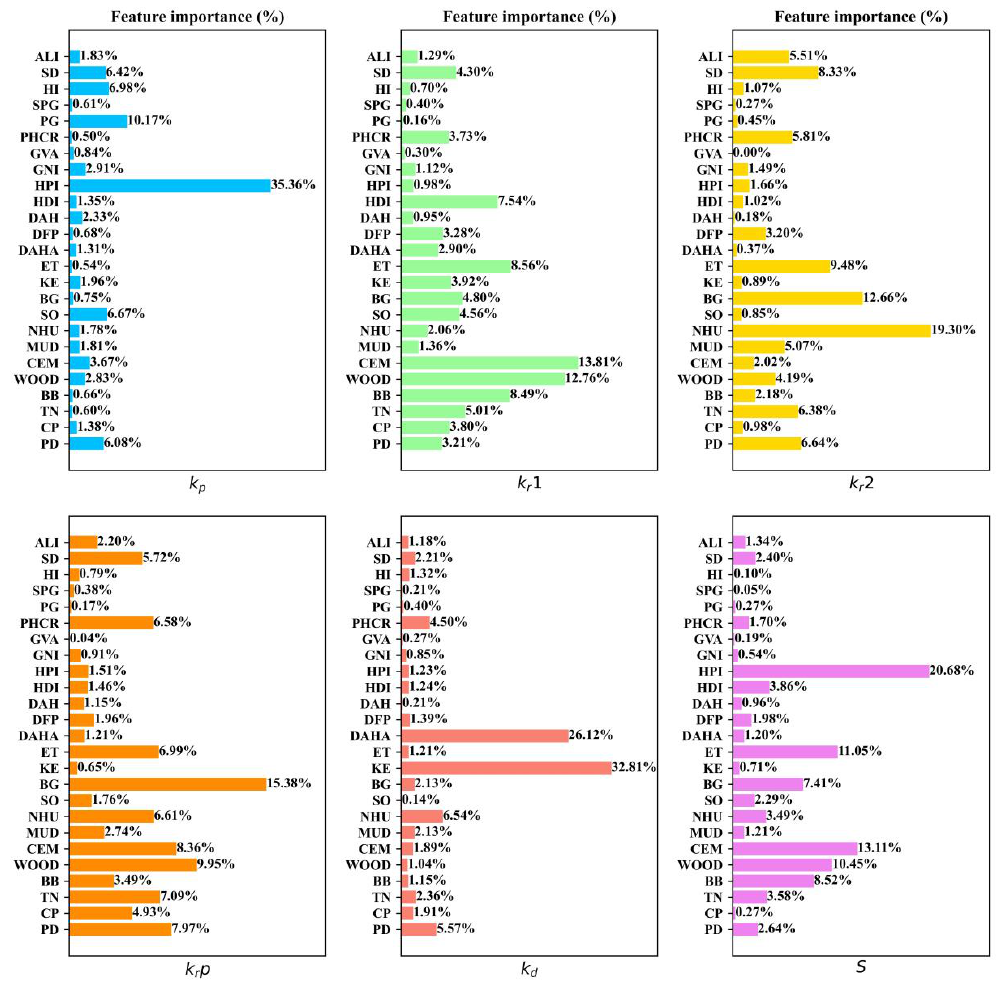
Figure 9. PNLP indicators feature importance. The abscissa represents the PNLP indicator, and the ordinate represents the socio-economic indicator. The indicator meaning is average light index (ALI), the total of structural damage (SD), the total of human injured (HI), squared poverty gap (SPG), poverty gap (PG), poverty head count ratio (PGCR), gross value added at basic price (GVA), GNI per capita based on purchasing power parity (GNI), human poverty index (HPI), human development index (HDI), percentage distribution of agricultural holdings (DAH), percentage distribution of farm population (DFP), percentage distribution of agricultural holding area (DAHA), lighting energy source (electricity (ET), kerosene (KE), bio-gas (BG), and solar (SO)), number of housing units (NHU), type of house walls (mud (MUD), cement (CEM), wood (WOOD), bamboo (BB)), transportation network (TN), percentage change in population (CP), and population density (PD), respectively.